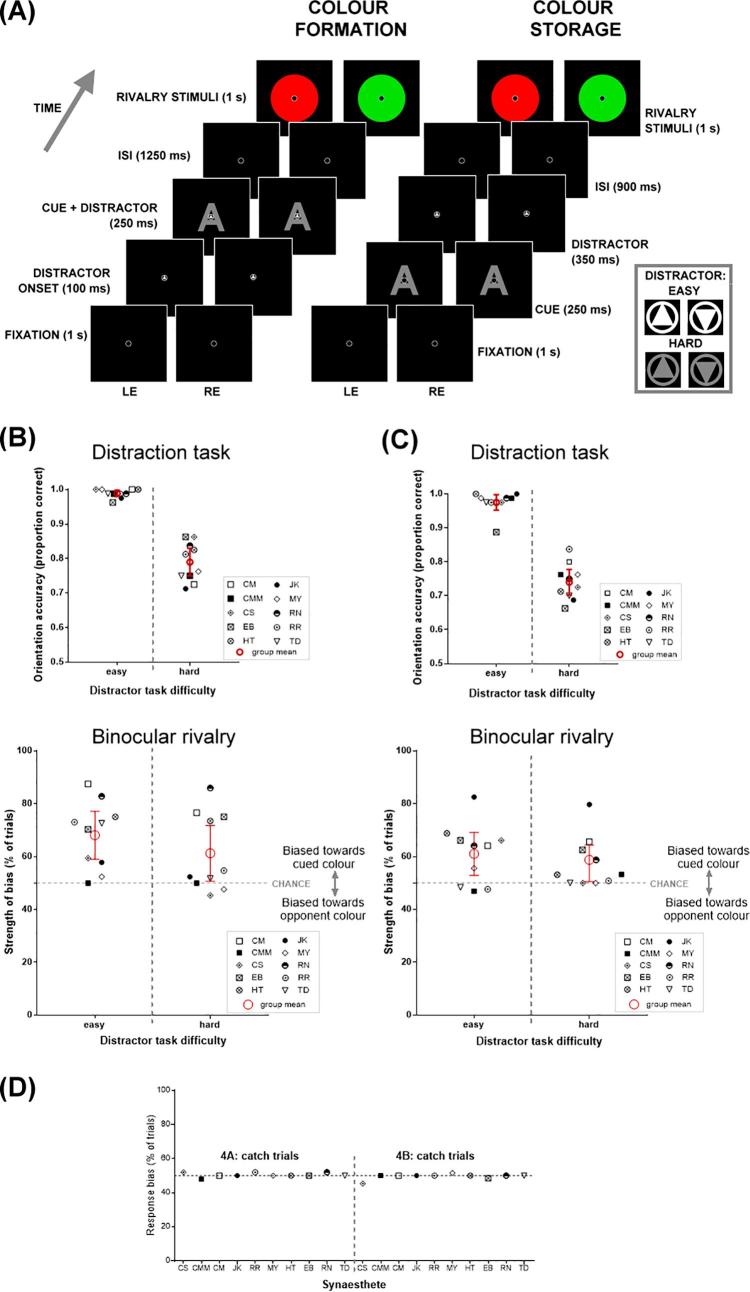
Experiment 4A and 4B: The effect of attention on the synaesthetic binocular rivalry effect.(A) Timeline of trial events of the synaesthetic colour formation (left) and synaesthetic colour storage (right) experiments. Example stimuli of the distraction task are illustrated in the box (far right), separated by orientation and difficulty (note that in the hard condition the contrast of the triangle varied with performance). (B) Experiment 4A Colour Formation data. Upper: Mean accuracy of distraction task performance, plotted by difficulty level. Lower: The strength of perceptual bias during binocular rivalry, separated by difficulty levels in the distraction task. Error bars show 95% confidence intervals. (C) Experiment 4B Colour Storage data. Upper: Mean accuracy of distraction task performance, plotted by difficulty level. Lower: The strength of perceptual bias during binocular rivalry, separated by difficulty levels in the distraction task. Error bars show 95% confidence intervals. (D) Response bias calculated from catch trials in the binocular rivalry task. Left: Experiment 4A; Right: Experiment 4B. (For interpretation of the references to colour in this figure legend, the reader is referred to the web version of this article.)